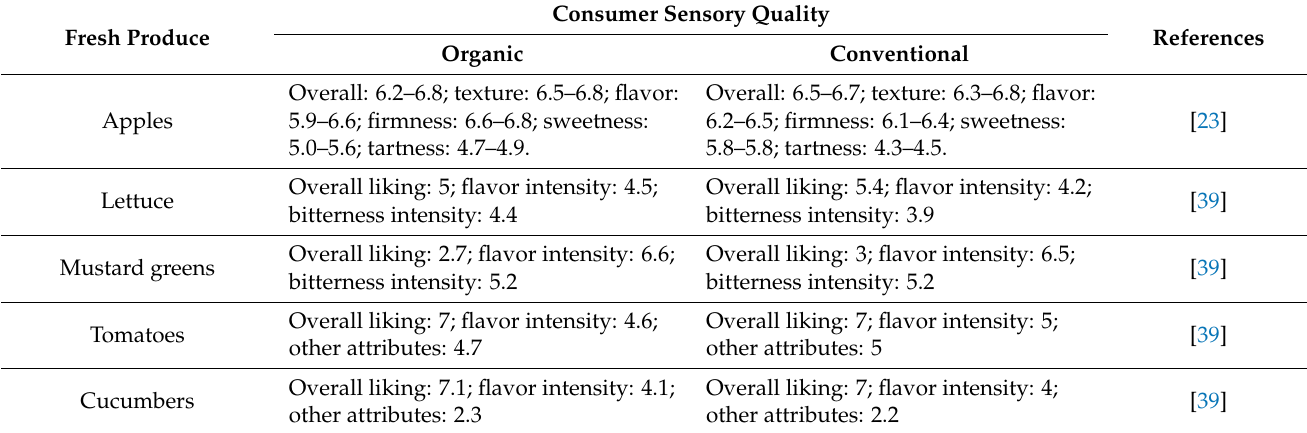
Table 4. Sensory quality of organic and conventional fresh produce based on a 9-point scale.